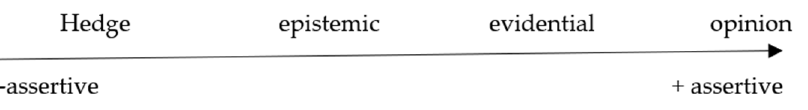
Figure 1. Discursive values of “I think” as a stance marker.